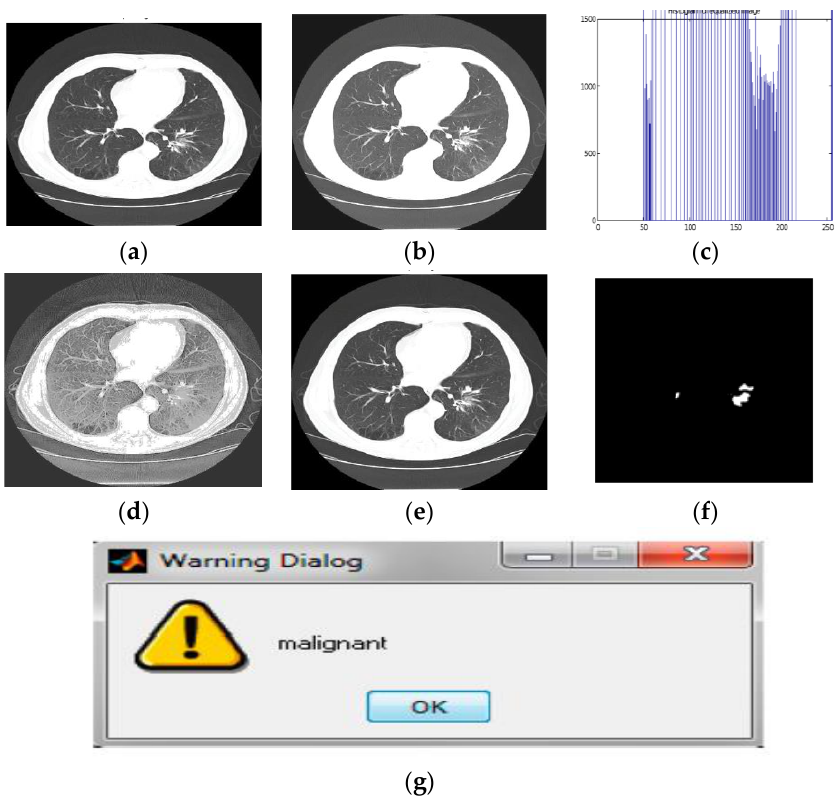
Figure 9. Detection of Benign Sample. ( a ) Input CT Image, ( b ) Pre-processed output, ( c ) Histogram Equalised Image Plot, ( d ) Histogram Equalised Image, ( e , f ) Segmentation image, ( g ) Classification result.